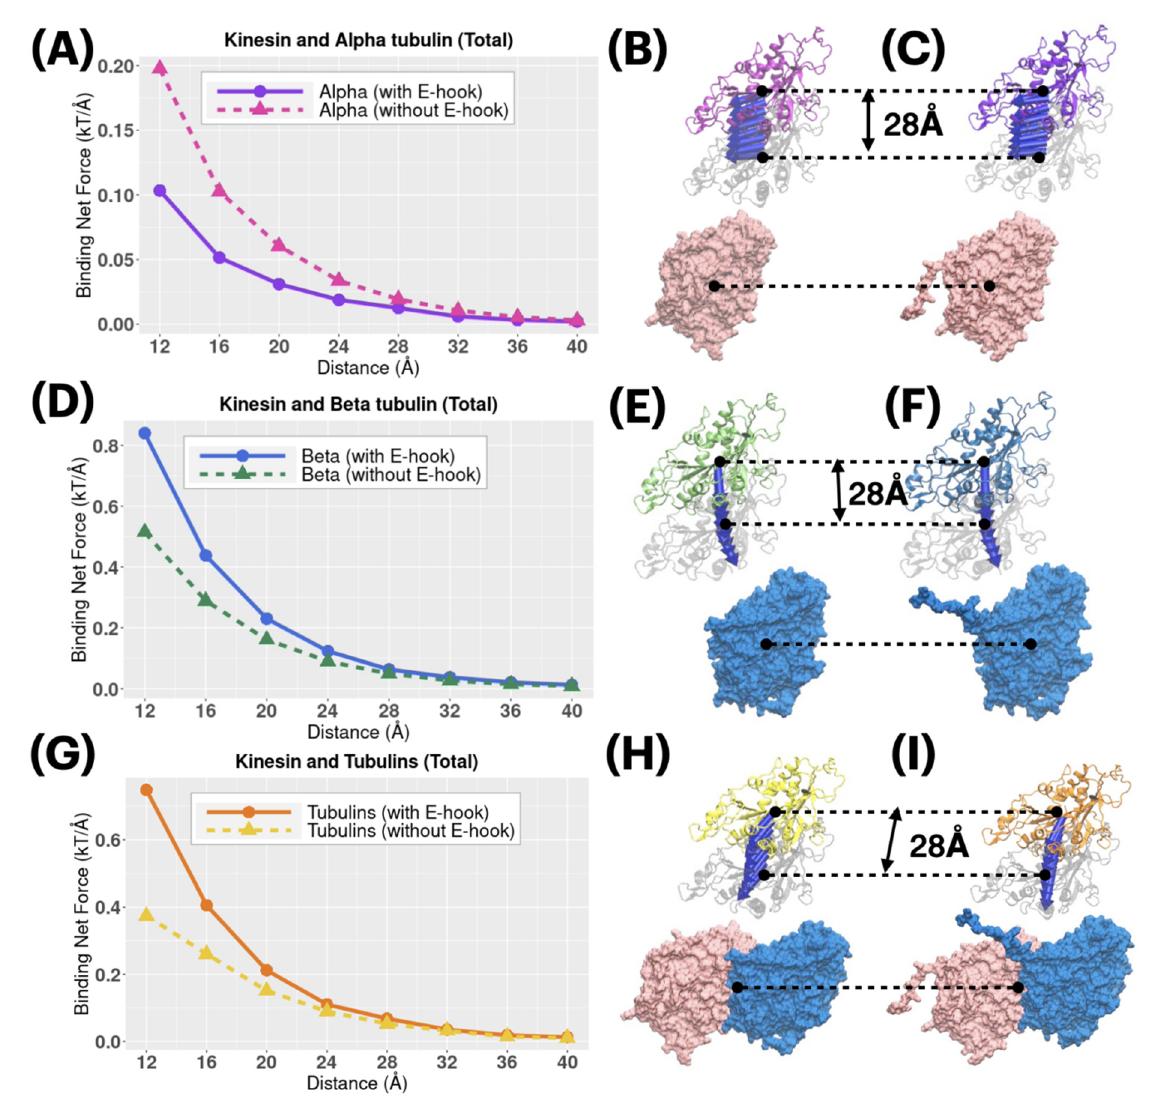
Figure 7. The electrostatic binding forces between kinesin and tubulins at different distances from 12 to 40 Å with the step size of 4 Å. ( A ) Binding net force strengths between Kinesin and Alpha tubulin (with/without E-hooks); ( B ) Binding net force directions between Kinesin and Alpha tubulin without E-hook; ( C ) Binding net force directions between Kinesin and Alpha tubulin with E-hook; ( D ) Binding net force strengths between Kinesin and Beta tubulin (with/without E-hooks); ( E ) Binding net force directions between Kinesin and Beta tubulin without E-hook; ( F ) Binding net force directions between Kinesin and Beta tubulin with E-hook; ( G ) Binding net force between kinesin and tubulin dimer (with/without E-hooks); ( H ) Binding net force directions between kinesin and tubulin dimer without E-hook; ( I ) Binding net force directions between kinesin and tubulin dimer with E-hooks. The blue arrows in Figure 7 BCEFHI represent the force directions and they were normalized to be of the same size for a better visualization.